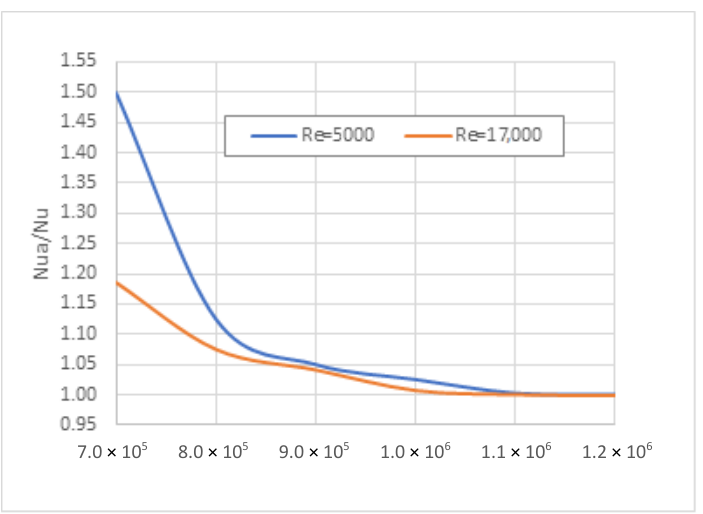
Figure 6. Nu number ratios against the mesh density.